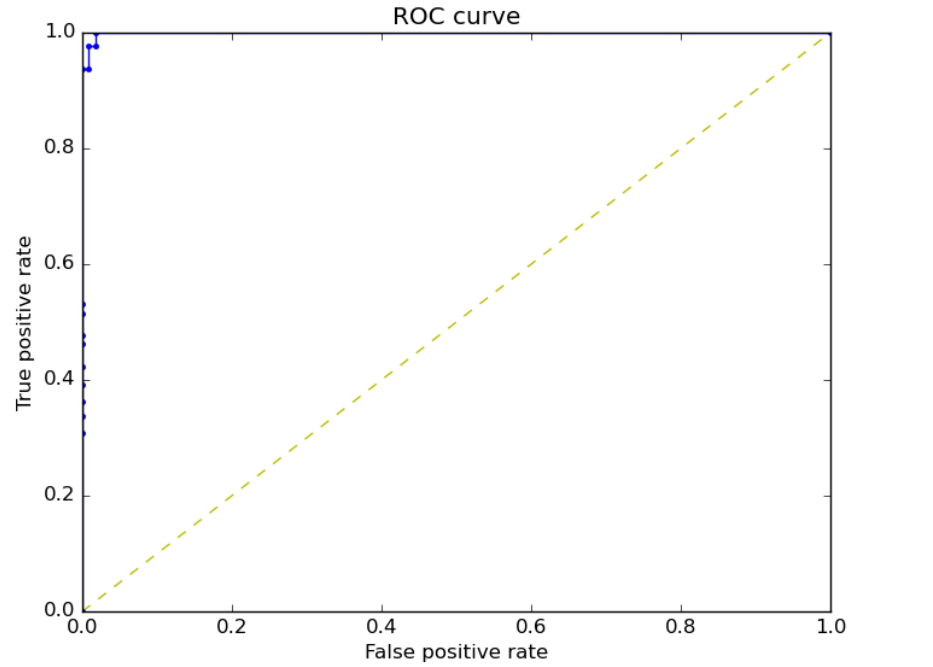
Figure 14. ROC Curves of the binary classification